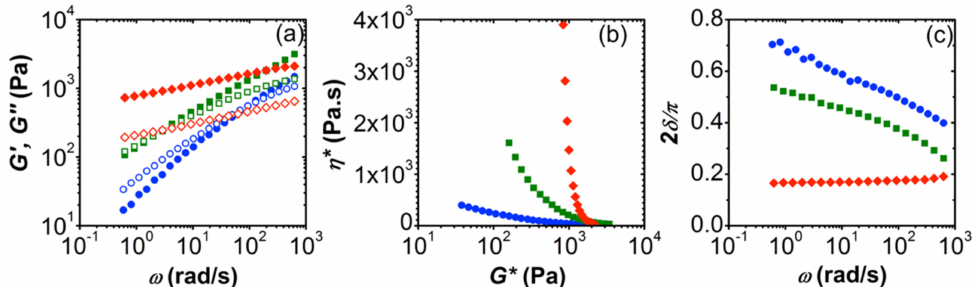
Figure 1. ( a ) Frequency sweep data of HA/CHI coacervates. Closed and open data points are for G (cid:48) (elastic modulus) and G ” (loss modulus), respectively. ( b ) Complex viscosity ( η ∗ ) versus complex modulus ( G *). ( c ) Normalized phase angle (2 δ / π ) versus angular frequency ( ω ). Red, green, and blue data points represent HA (750 kDa)/CHI (123.5 kDa, F A = 0.42), HA (132.3 kDa)/CHI (365.1 kDa, F A = 0.46), and HA (132.3 kDa)/CHI (123.5 kDa, F A = 0.42) coacervates,